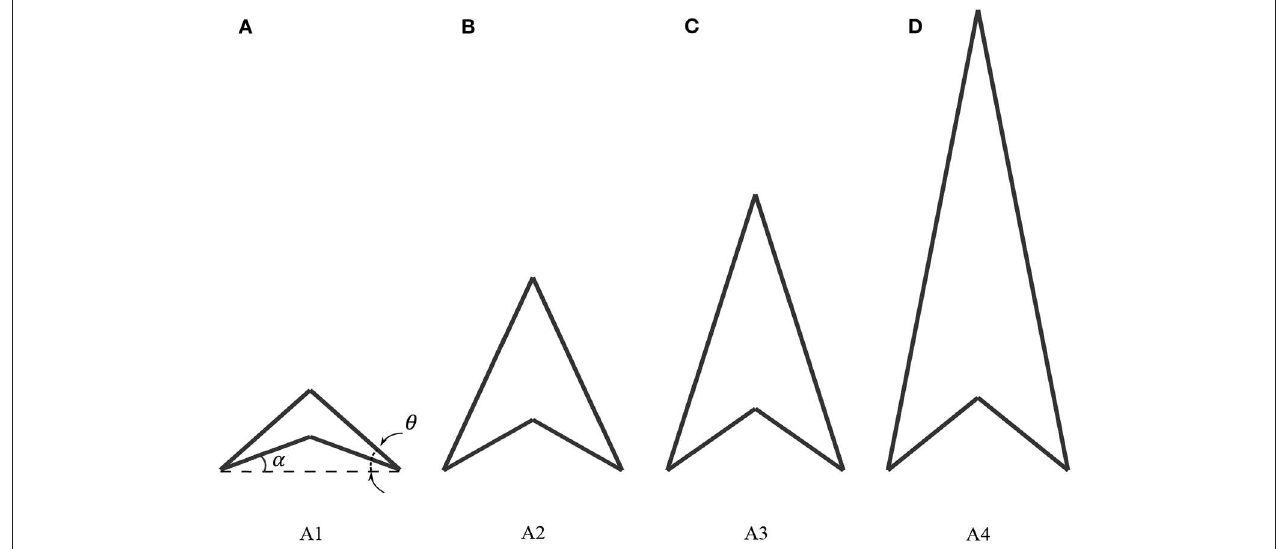
FIGURE 6 | Arrowhead cells with respective varying inclination angles θ and α with (A) A1: 45.0 ◦ , 22.5 ◦ , (B) A2: 60.0 ◦ , 30.0 ◦ , (C) A3: 70.0 ◦ , 35.0 ◦ , and (D) A4: 80.0 ◦ , 40.0 ◦ , respectively. The breadth B is kept constant for all cases hence there are variations in height.